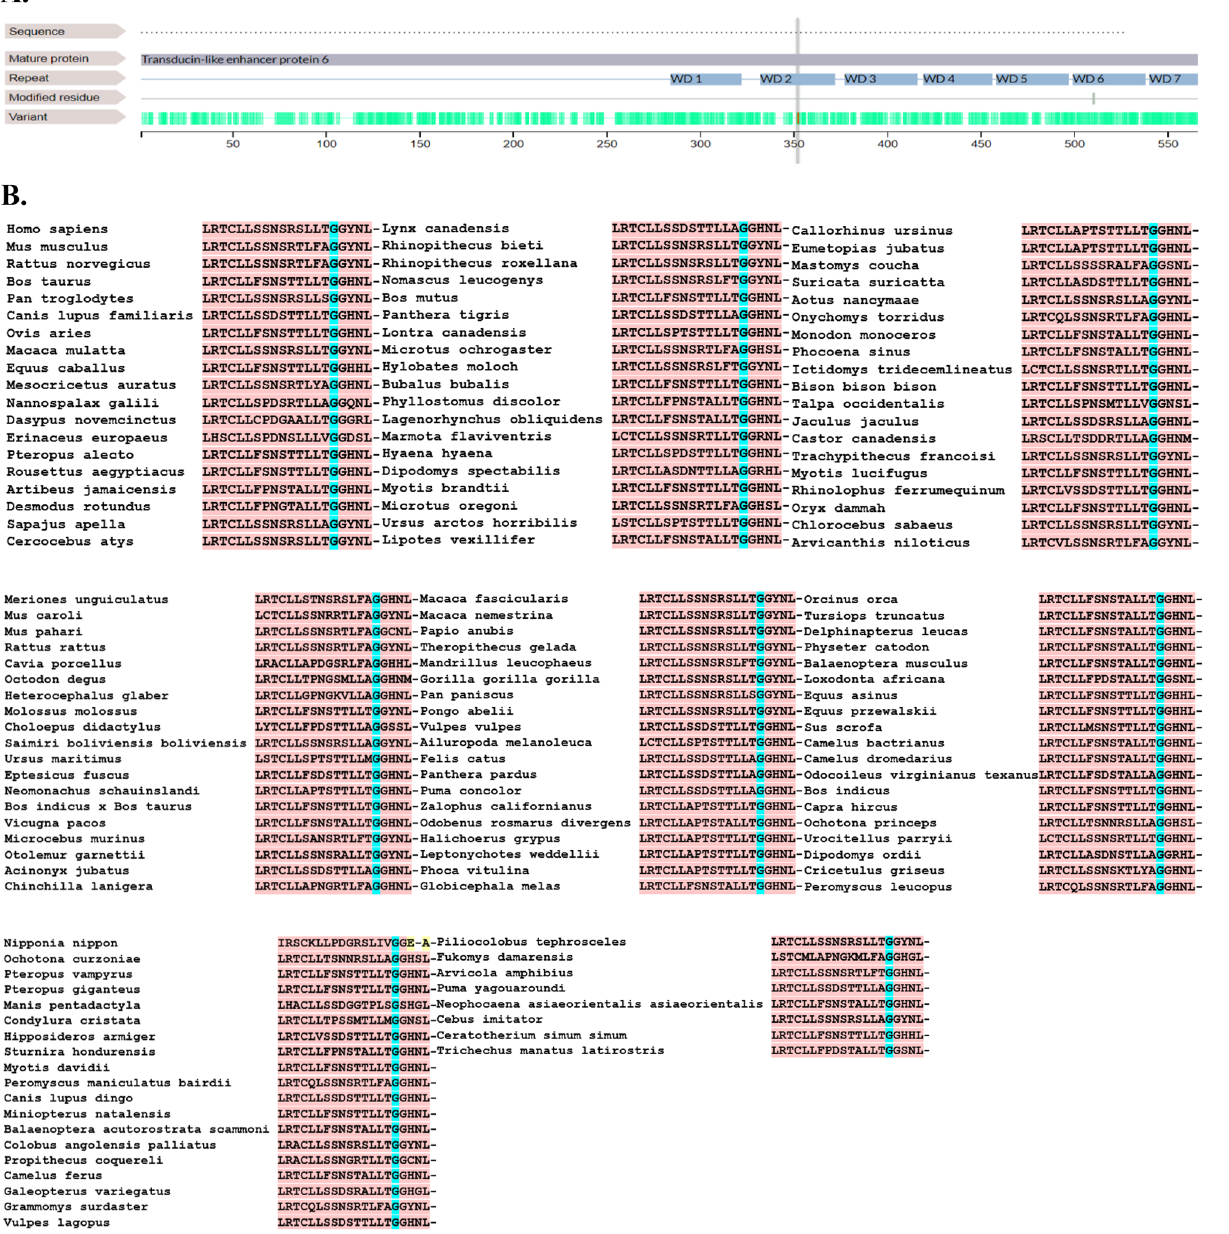
Figure 2. The locations and conservation of mutated residues in TLE6 ( TLE6 :NM_001143986:exon13:c. G1054C:p.G352R). ( A ) The position of the variant is indicated in the genomic structure and protein structure of TLE6. ( B ) Conservation of mutated amino acids in TLE6 among 141 different taxonomies. The residue G352 is highly conserved across